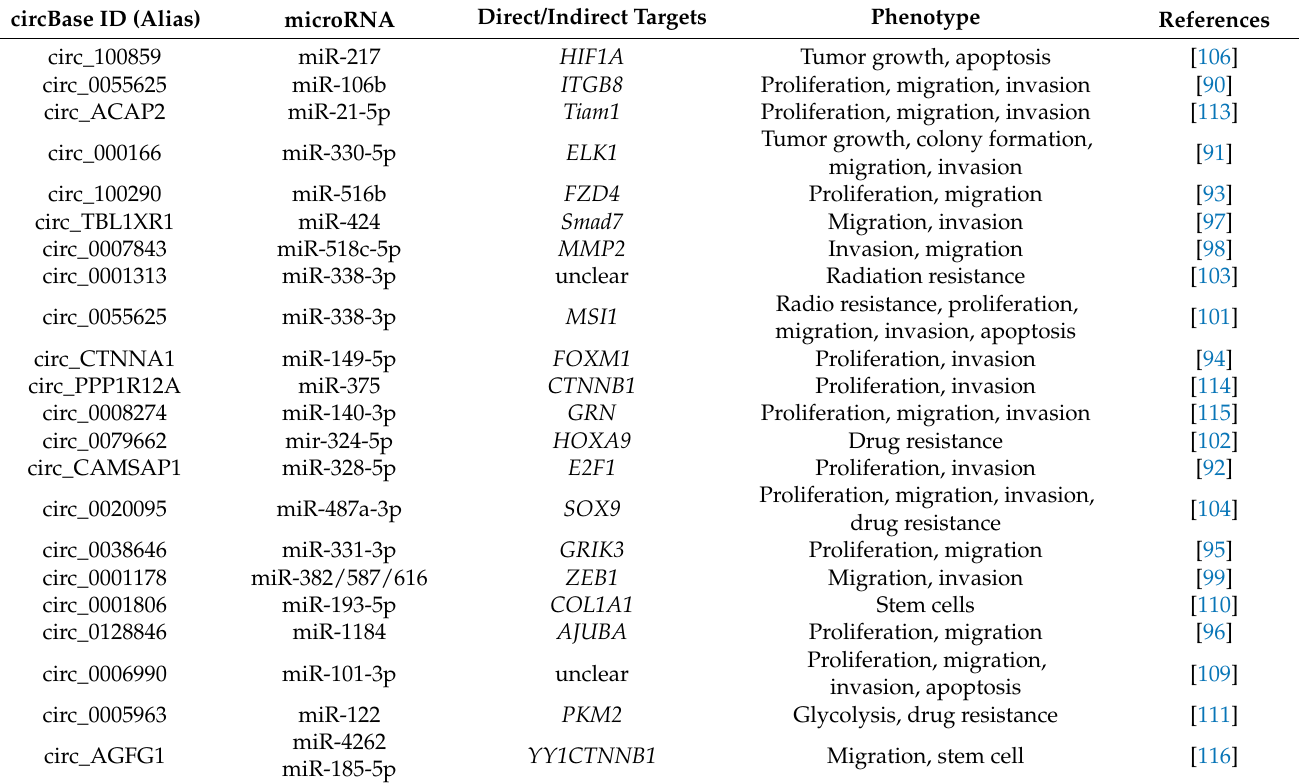
Table 3. The sponge functions of cancer-promoting circRNA in